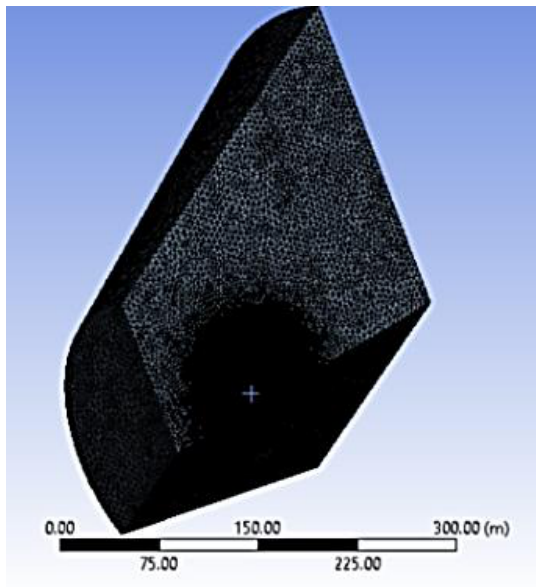
Figure 12. Mesh geometry generation with the number of mesh elements in ANSYS Fluent.